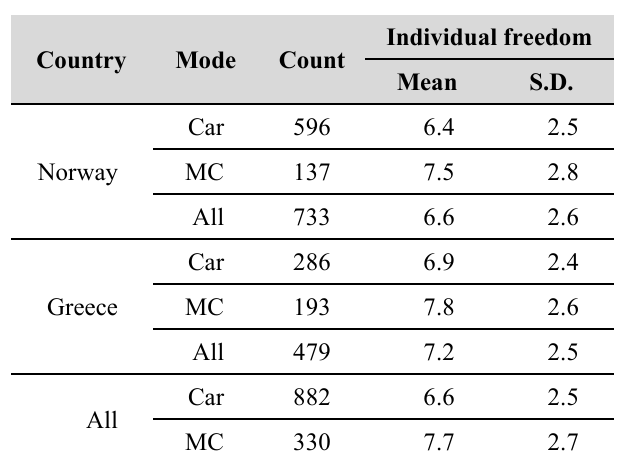
Table 2 Mean scores on the index for individual freedom to take risk in traffic among car drivers and motorcycle riders in the two